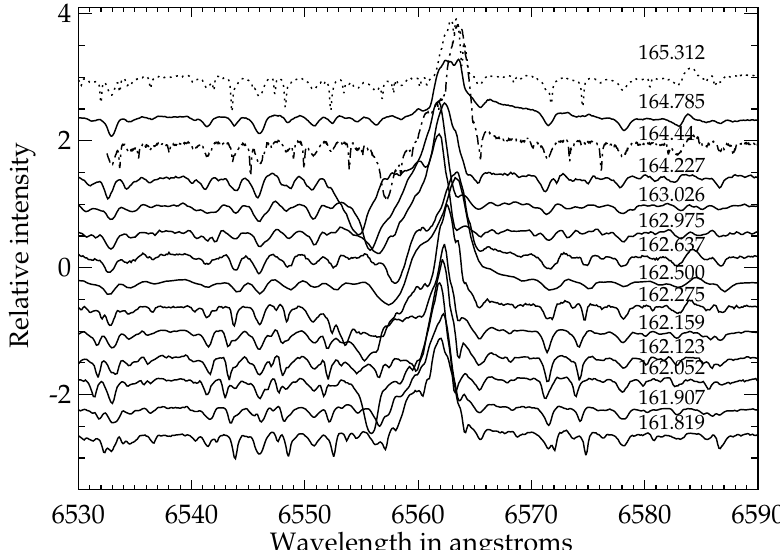
Fig. 9. The same as in Figure 7 but for cycle 162. The spectrum observed by Alex Rosenbush (Rosenbush 2011) is plotted by a dash-dotted line. The spectra at the phases 164.227, 164.44 and 165.312 are obtained at SAO for this work. Note the variability of the [N II] line at 6583 (cid:23)A